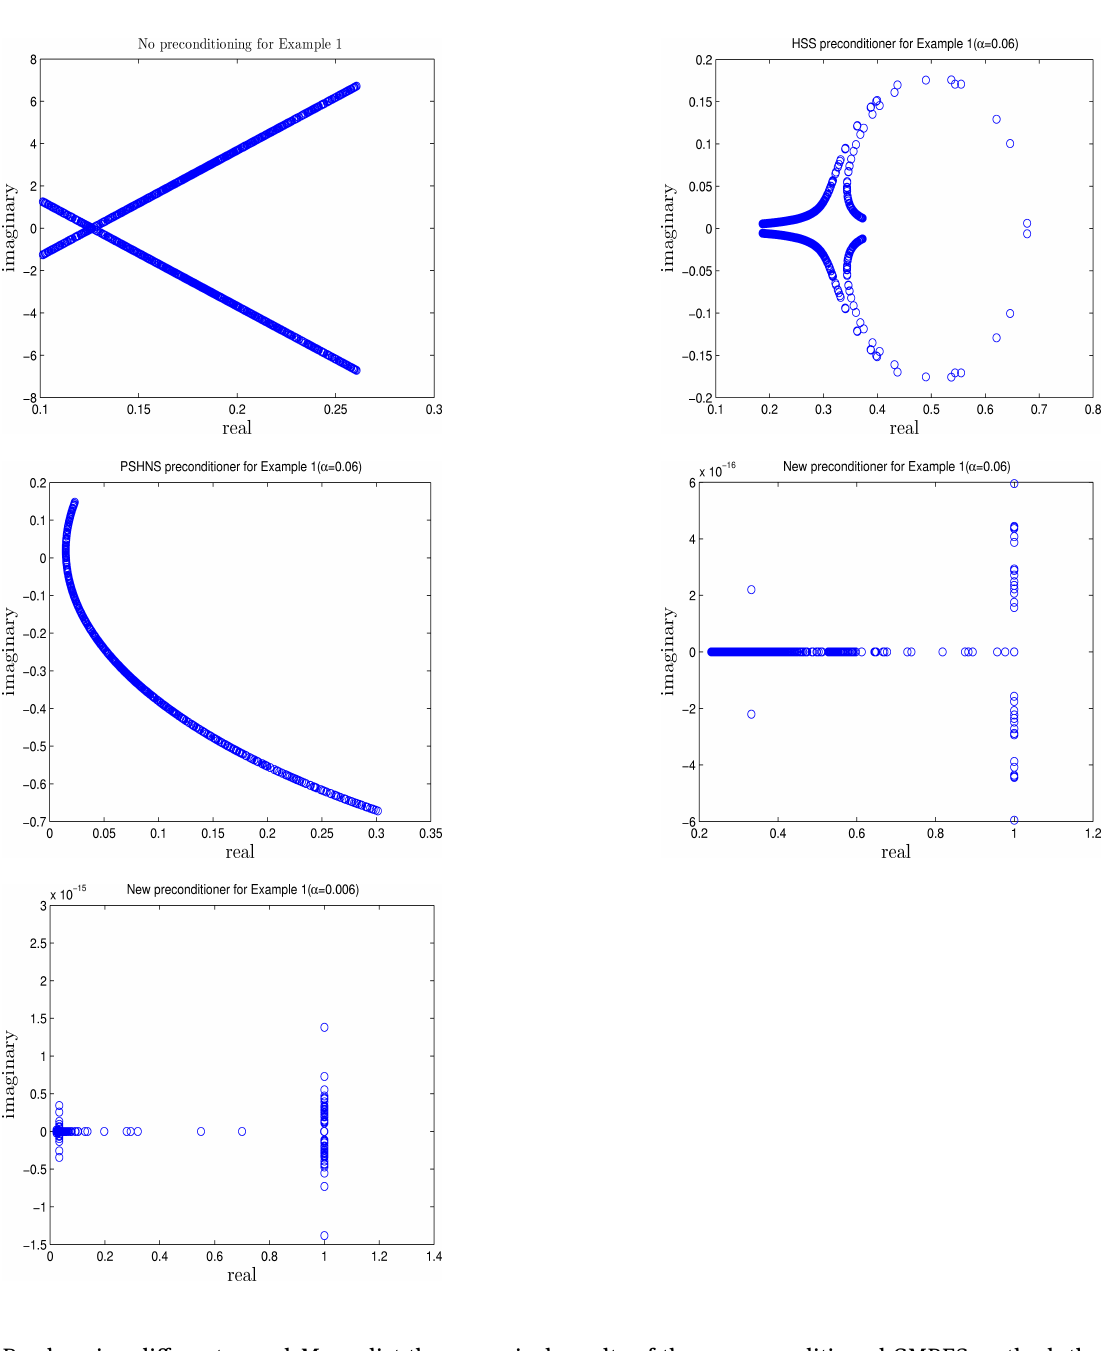
Fig. 1. The eigenvalue distributions of unpreconditioned matrix, the preconditioned matrices P − 1 Example 1 with M = 35 I